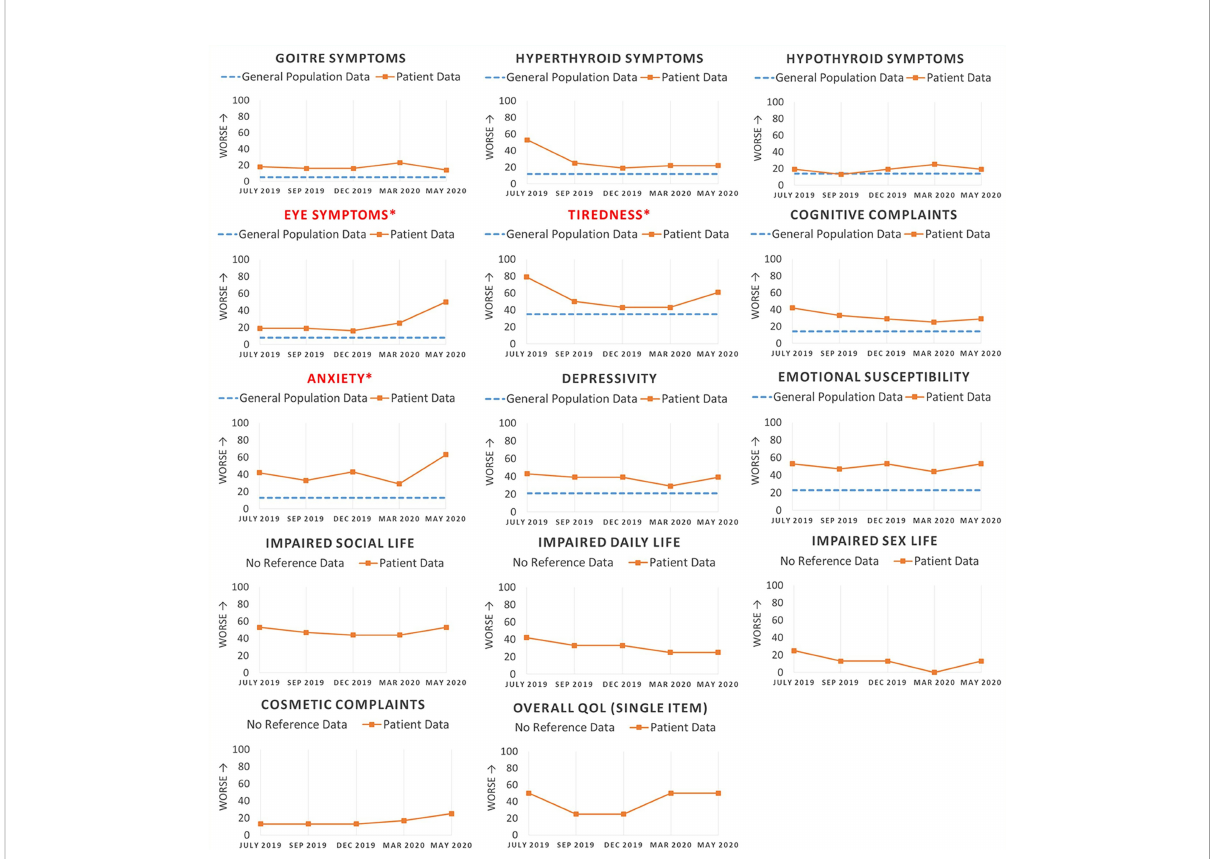
FIGURE 2 This fi gure illustrates how multiple longitudinal quality of life assessments can be presented to the clinician in the electronic health record. In this made-up example, a patient with newly diagnosed Graves ’ disease completes the ThyPRO survey before each consultation. An indicator of worse QoL is seen to the left of the vertical axis as some PROs are scored opposite than ThyPRO (i.e. higher scores indicate better QoL). Reference scores are shown with blue dotted lines to facilitate the interpretation of patient scores. Scales are marked with an asterisk sign (*) and the scale name highlighted in red if the scores have deteriorated more than the MIC (minimal important change) (29), enabling the clinician to get a fast overview of domains with worsening QoL. Note: Items in scales of the two bottom rows are asked with attribution to thyroid disease and cannot be answered by respondents from the general